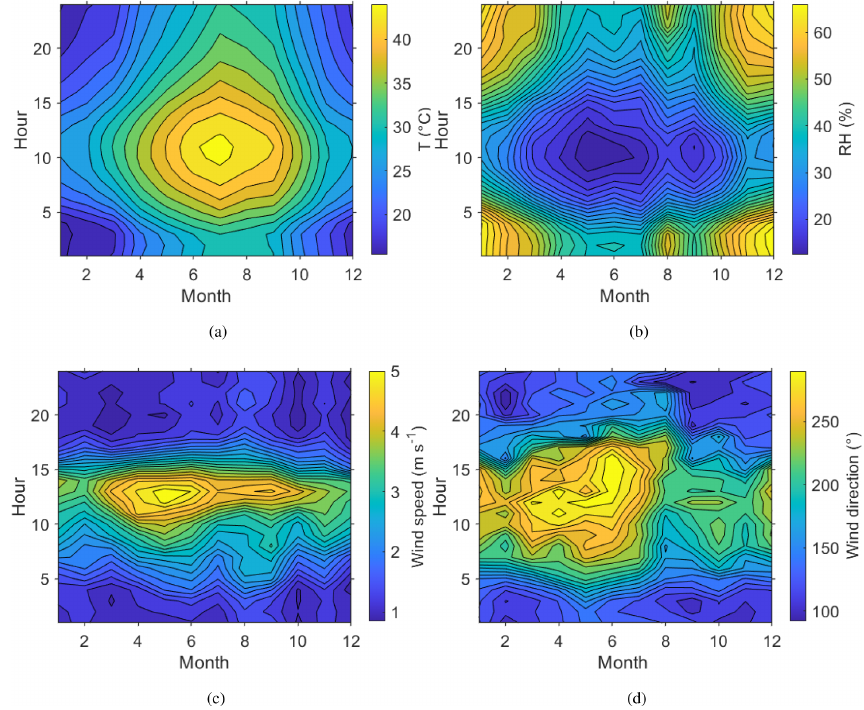
Figure 2. Seasonal and diurnal variation in surface (a) temperature, T ( ◦ C); (b) relative humidity, RH (%); (c) wind speed, WS (ms − 1 ); and (d) wind direction, WD ( ◦ ). All measurements made at 7ma . g . l .